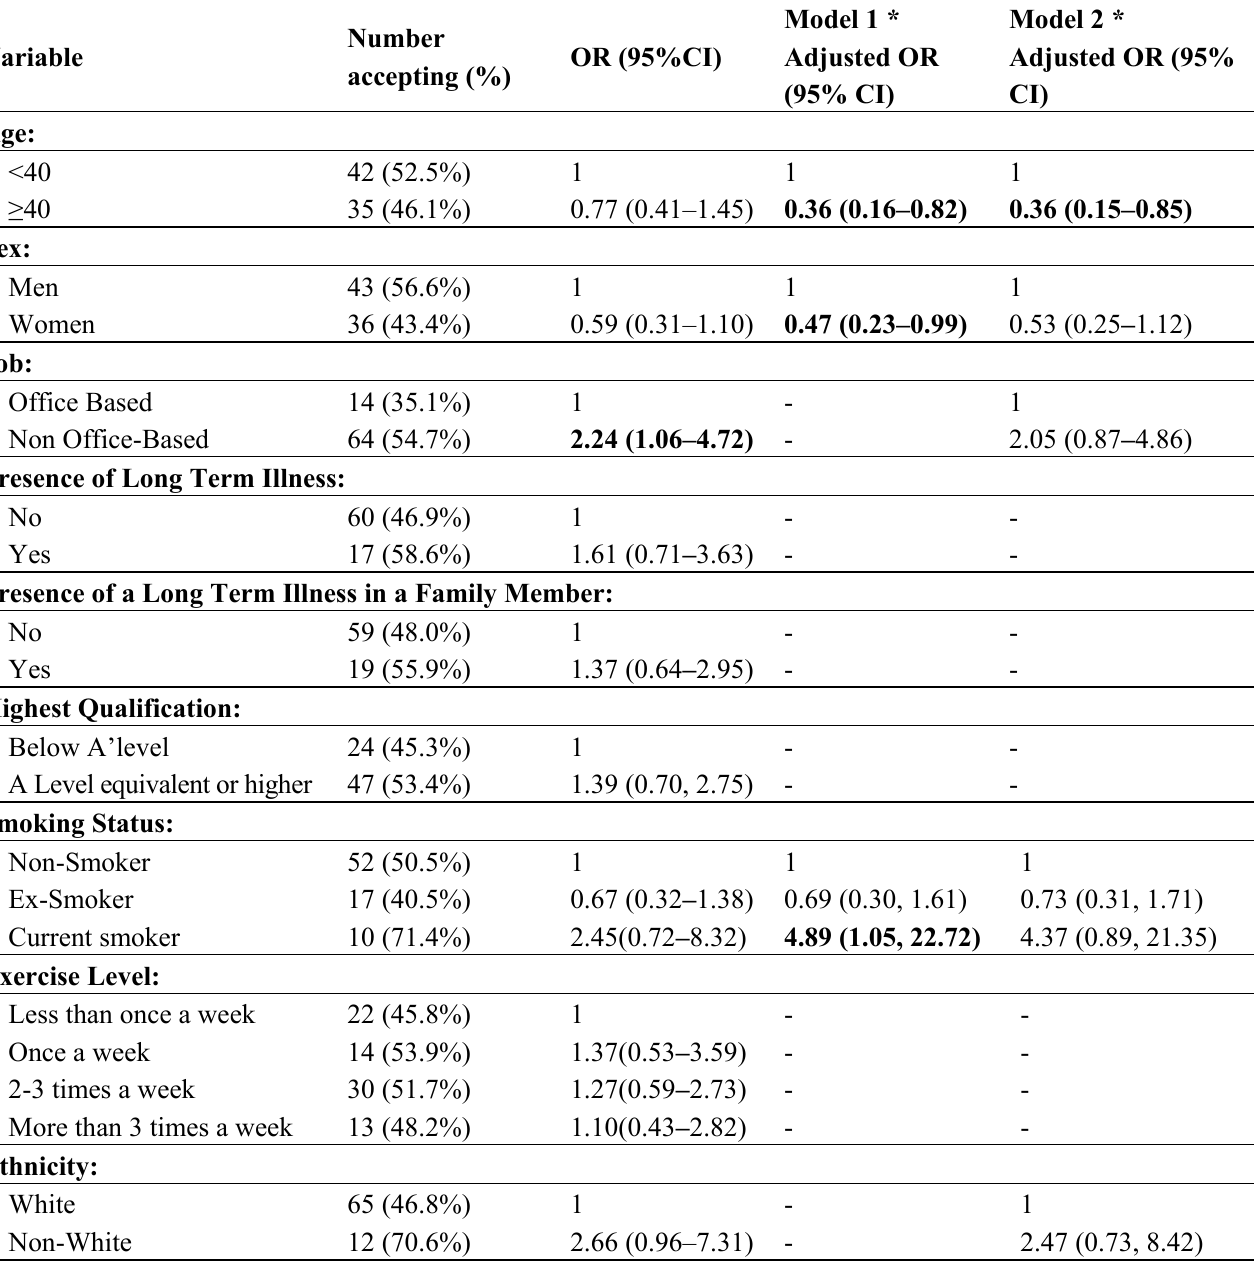
Table 3. Determinants associated with intention to accept the Pandemic Influenza A (H1N1) 2009